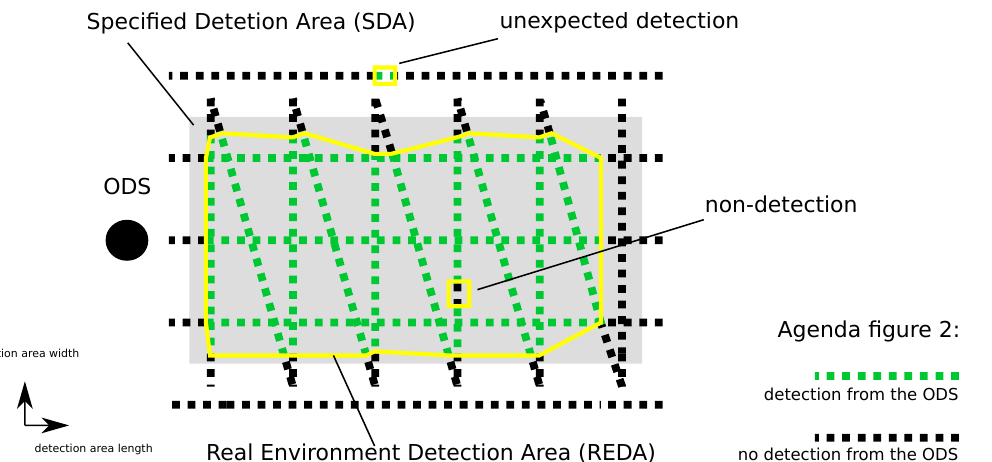
Figure 2. This figure shows the creation of a real environment detection area (REDA, yellow lines). Reprinted from Ref. [14].